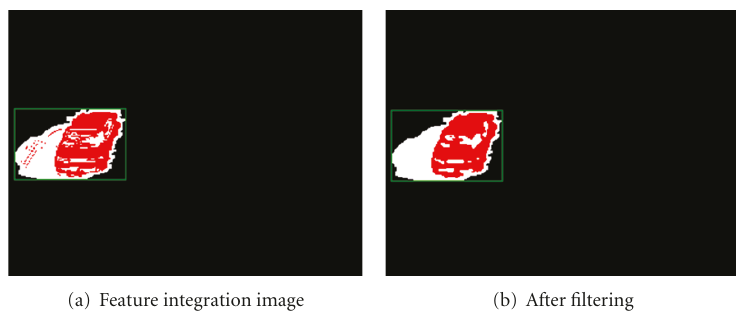
Figure 23: Filtering by median filter for feature-integration